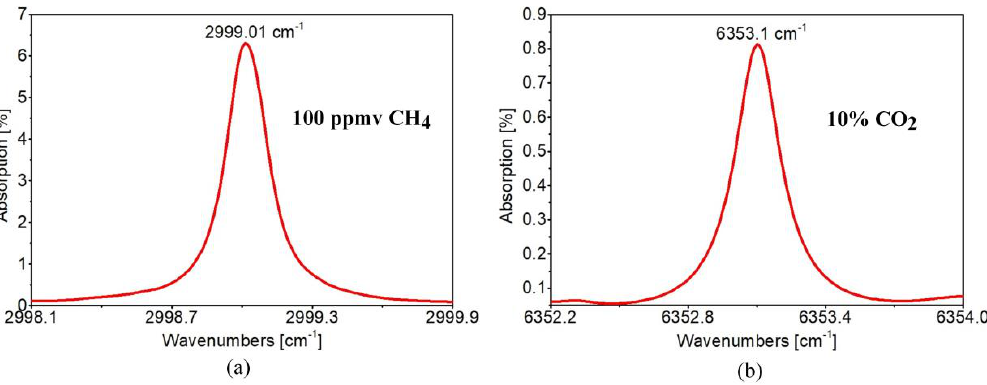
Figure 5. Absorption spectra of target transitions of: ( a ) 100 ppmv CH 4 ; ( b ) 10% CO 2 both simulated for 1 m path length and 800 Torr pressure using the HITRAN database [34].